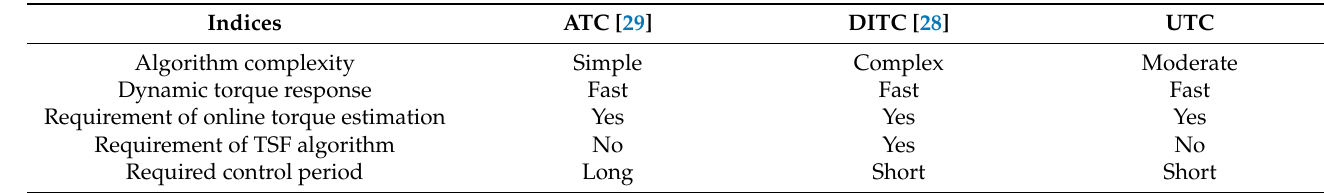
Table 2. Summary of comparison results regarding control